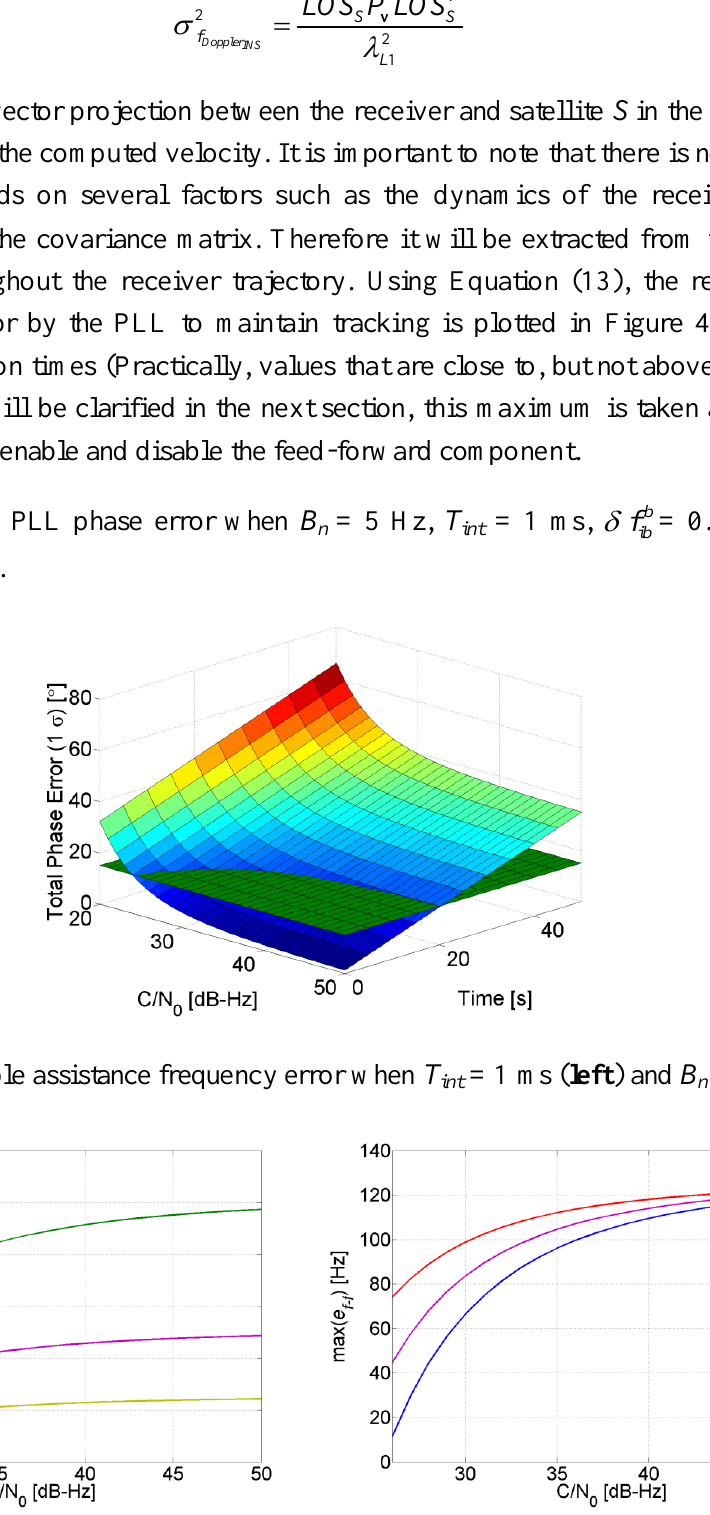
= 5 Hz, T = 1 ms, b f  = 0.12 m/s 2 , and n int ib